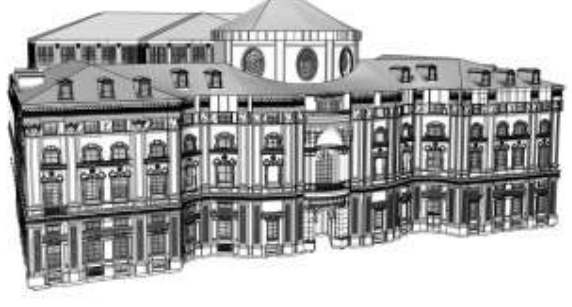
Figure 6. 3D Model of Palazzo Carignano project by Guarino Guarini. F. Giusti, I. Giai Via, A. Quarati, 2014.